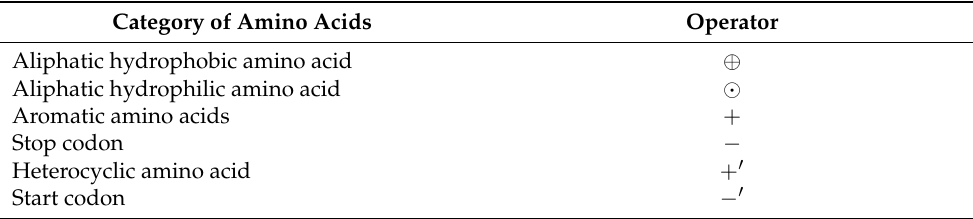
Table 9. Correspondence between amino acid category and operator.